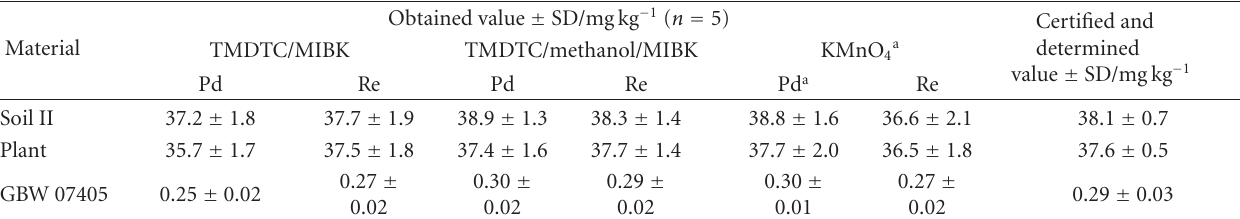
Table 4: Results obtained for mercury content in environmental materials using SS-ETAAS with modification of platform surface and calibration against calibration solutions.